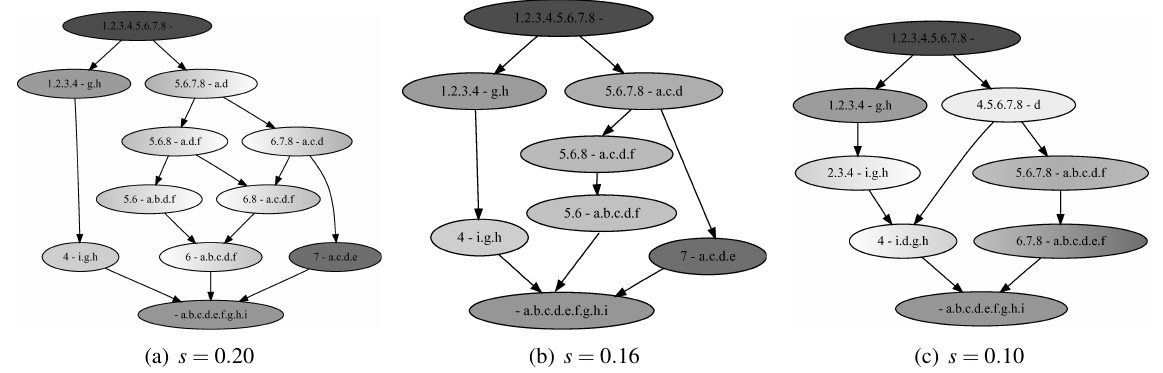
Figure 3: Lattices of formal concepts for different values of the threshold (example of Figure 2, with W given in Table